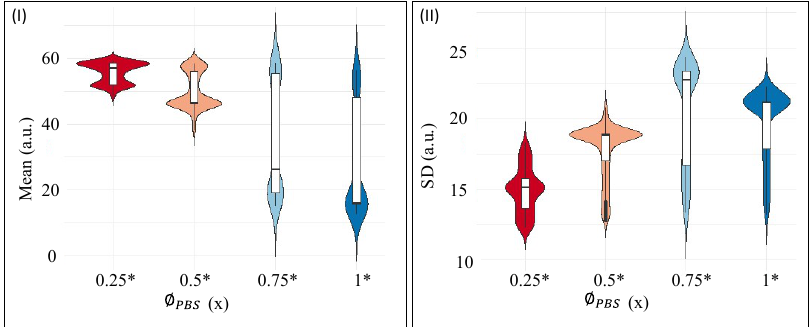
Figure 7. Violin plots for the first-order textural parameters—( I ) represents the distribution of Mean, and ( II ) displays the distribution of Standard Deviation (SD) of the protein drops at different initial concentrations of PBS ( φ PBS ). The significant φ PBS is marked with an asterisk (*). The protein drops have a fixed initial concentration of 9 wt% that do not contain any liquid crystals (LCs).